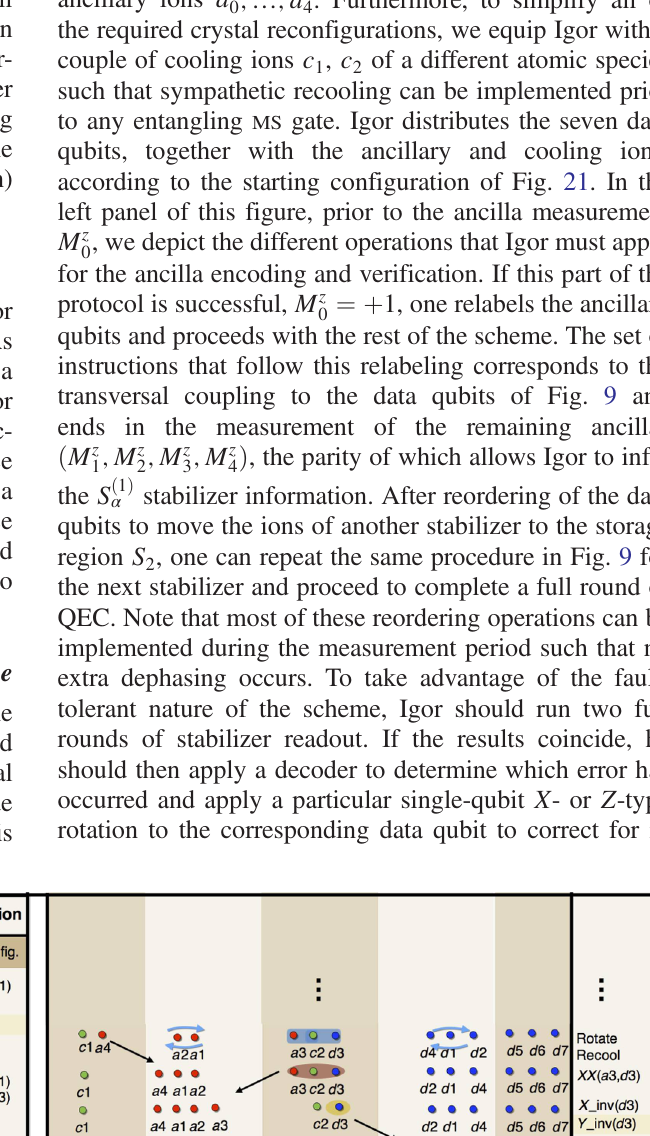
1 Þ α , either for α ¼ x or z , in two panels,